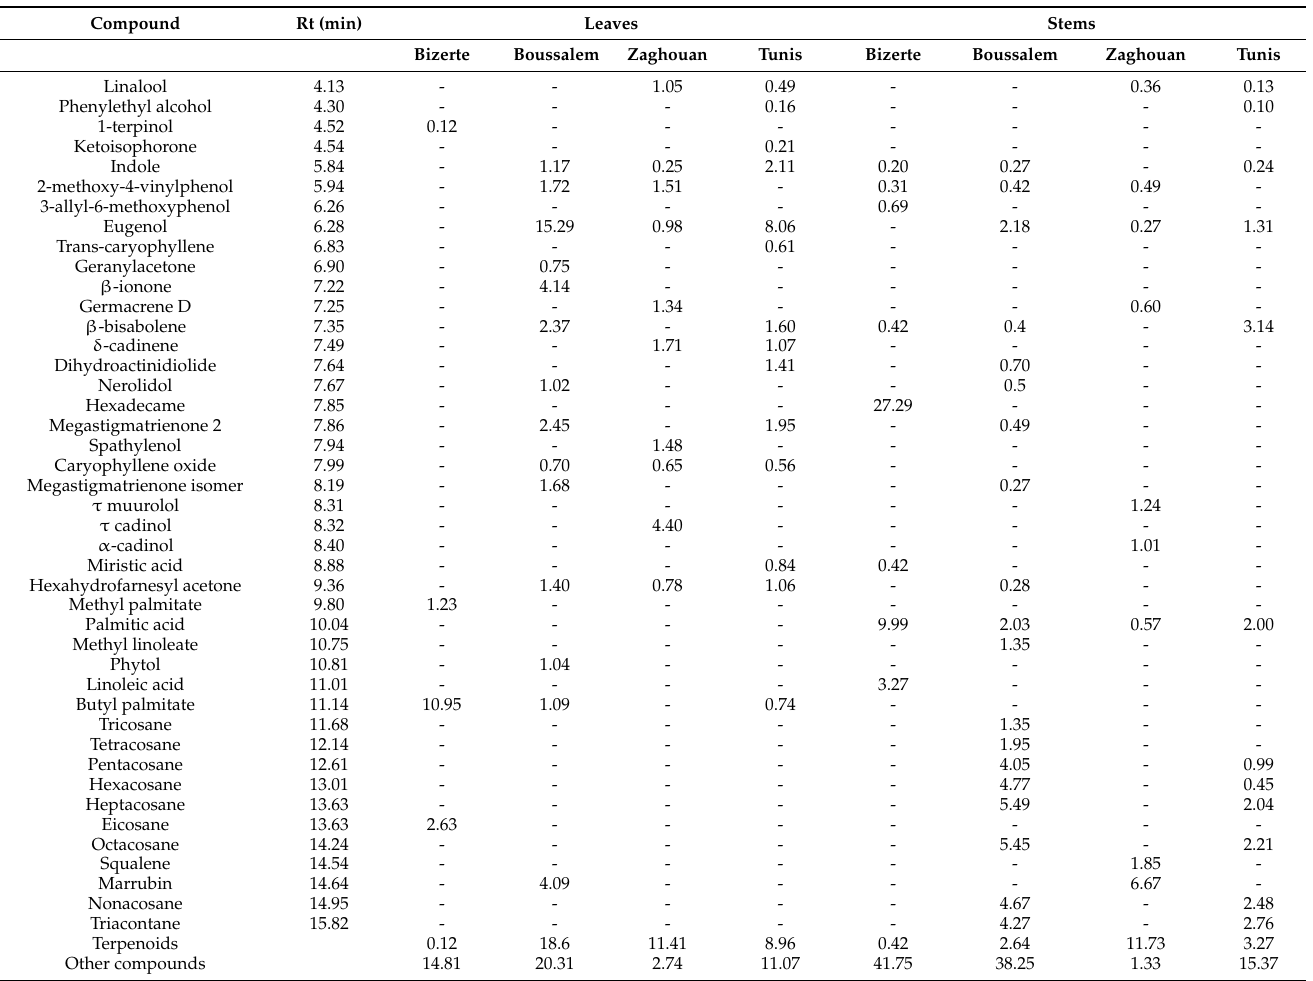
Table 6. Composition of M. vulgare essential oil collected at different locations in Tunisia. Compound Rt (min) Leaves Stems